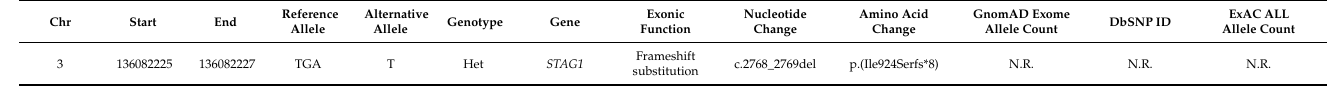
Table 1. Characteristics of the variant identified in the STAG1